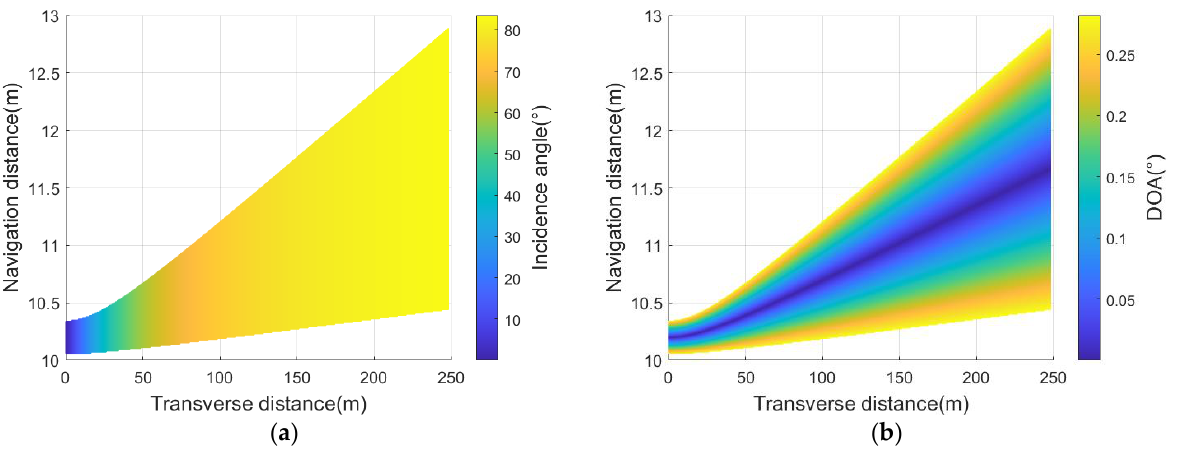
Figure 7. Echo parameters in the receiving beam footprint (Figure 6c): ( a ) incident angle; ( b ) DOA.